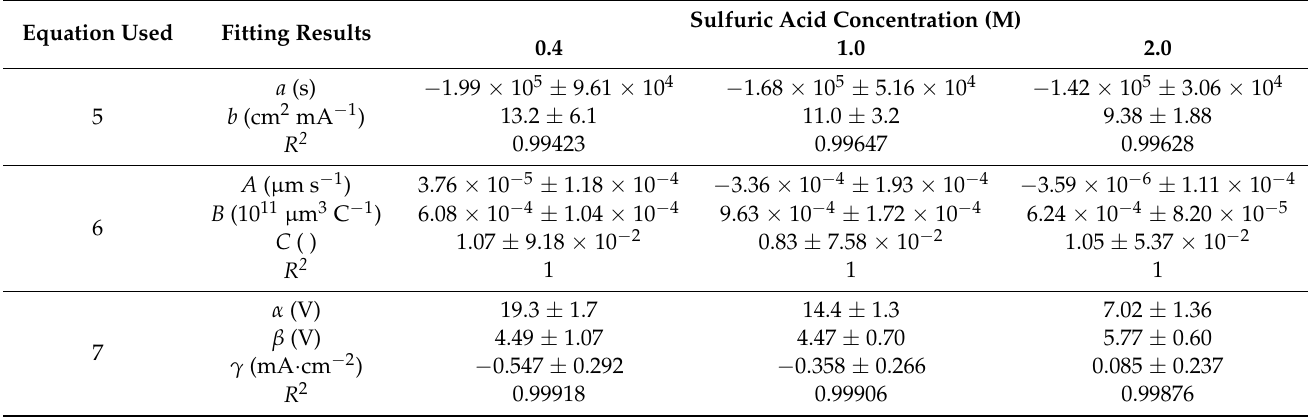
Table 1. Best fitting parametric values and standard errors from model Equations (5)–(7) for anodizing time τ , anodizing rate V a , and anodic voltage E a , respectively, for different sulfuric acid